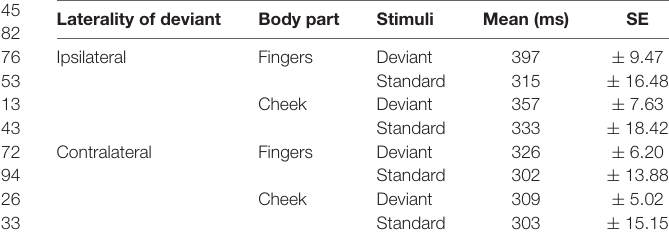
TABLE 5 | Mean latencies of P300 with SE